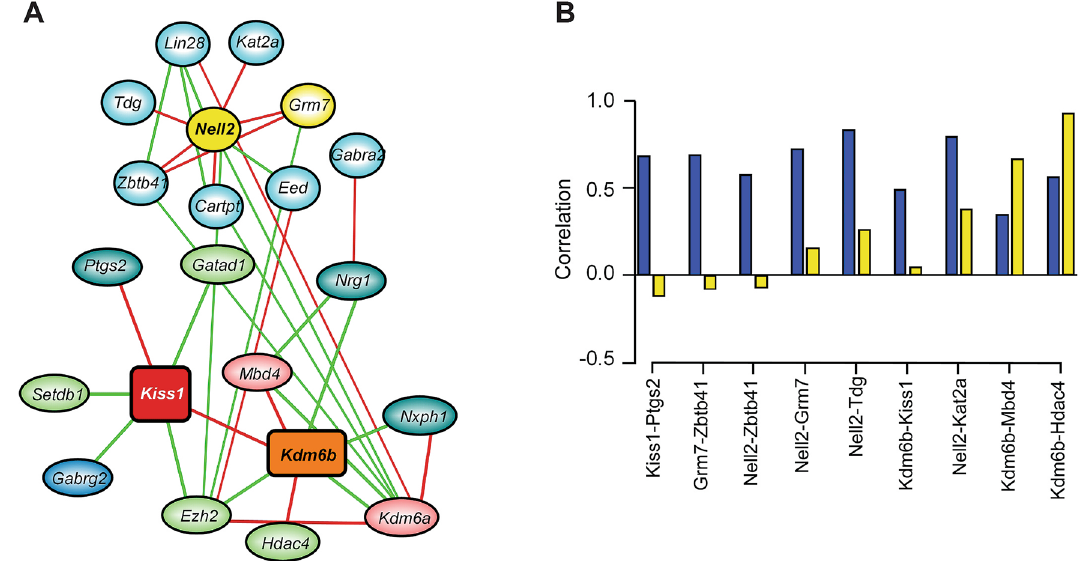
Figure 3. Gene co-expression networks in the MBH of immature female rats injected with either LV-GFP or LV-EED in the ARC. ( A ) First and second-neighbor network of strong co-expression edges for Kiss1 and Kdm6b . Positively correlated edges are red, negatively correlated edges are green. First neighbors involved in primarily negative epigenomic regulation are indicated in light green ovals, while positive epigenomic regulators are indicated in red ovals. Non-epigenetic genes are blue ovals. Glutamatergic-related genes are indicated in yellow ovals, other in cyan ovals. ( B ) Histogram depicting expression correlations of pairs of genes